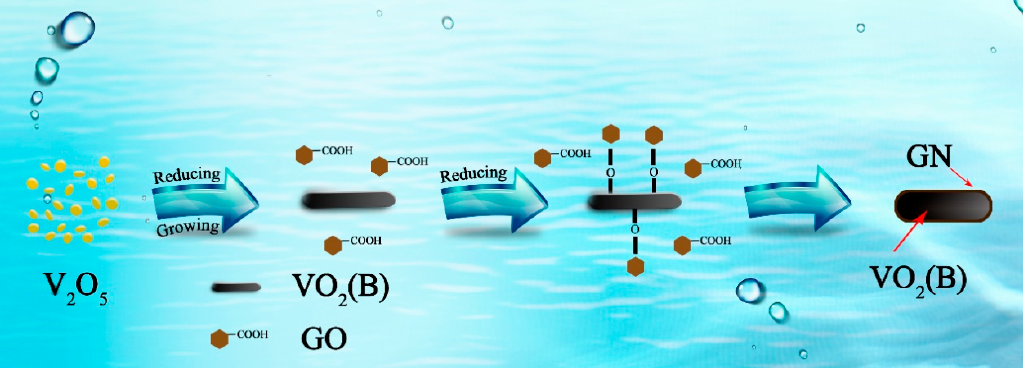
Figure 2. ( a ) FT-IR spectra of VO 2 (B), GO, and VO 2 (B)/GN composite, XPS spectra of VO 2 (B)/GN composite: ( b ) Survey peak; ( c ) typical V 2p; ( d ) typical C 1s and ( e ) typical O 1s. Table 1. XPS analysis of VO 2 (B)/GN.